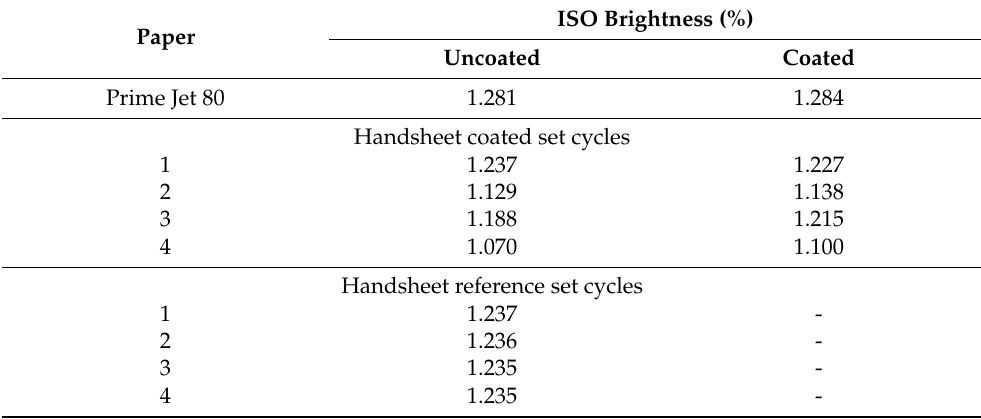
Table 7. ISO brightness for Prime Jet 80 and